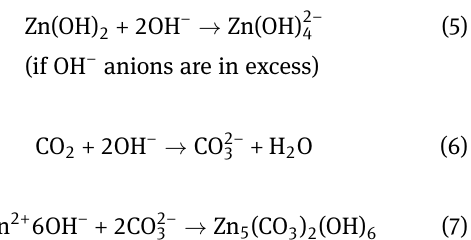
tial architecture is changed, as follows. The